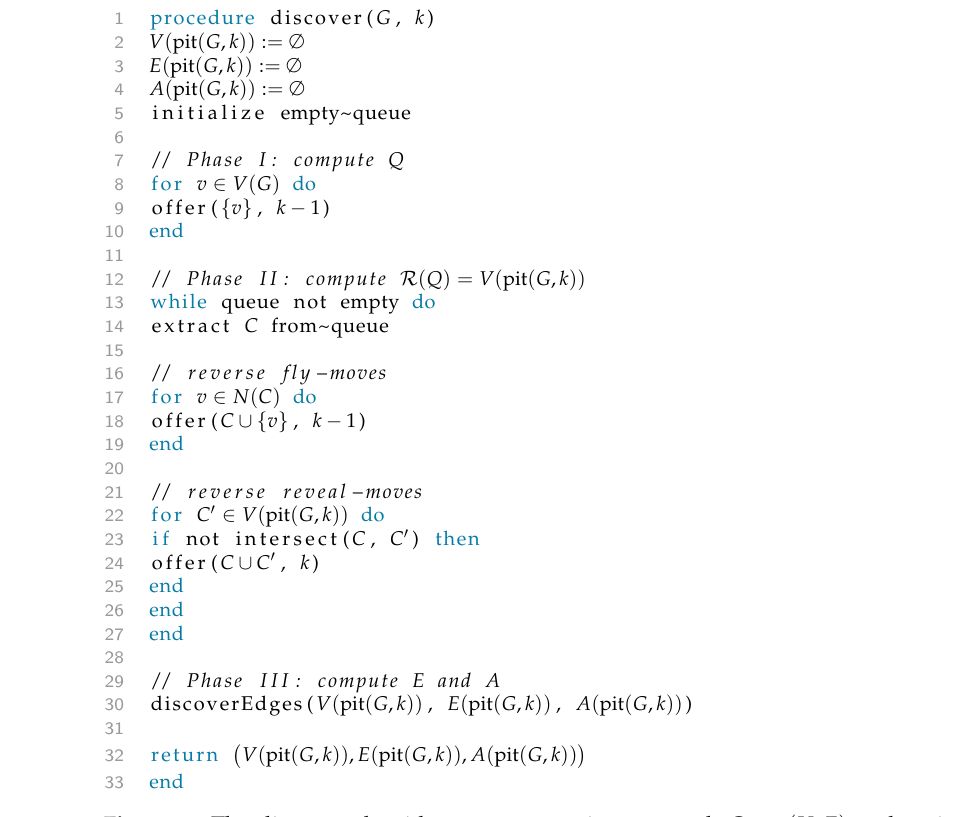
Figure 5. The discover algorithm computes, given a graph G = ( V , E ) and an integer k the auxiliary graph pit ( G , k ) . Using the positive-instance driven paradigm, only the elements of the pit are explored during this process. The executed subprocedures can be found in Figure 6.